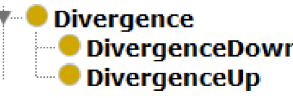
Figure 9. The Divergence